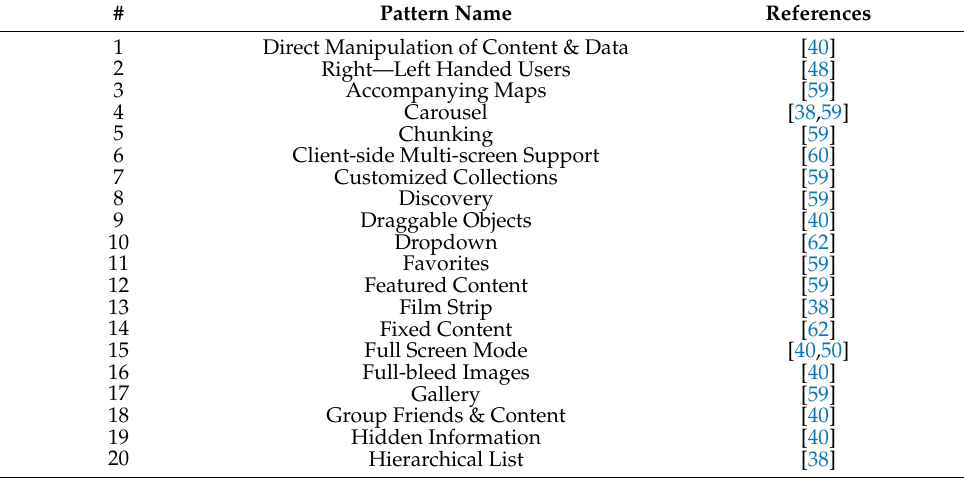
Table 21. Organizing the Content